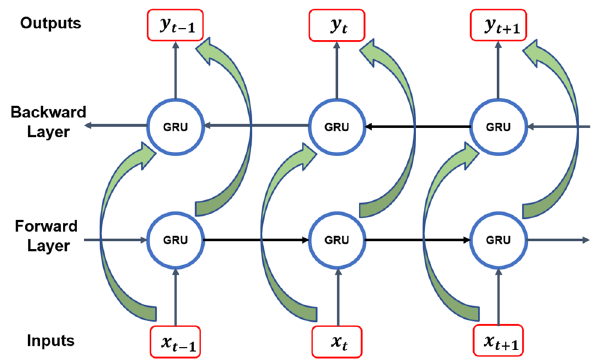
Fig. 3 Schematic diagram of bi-directional gated recurrent